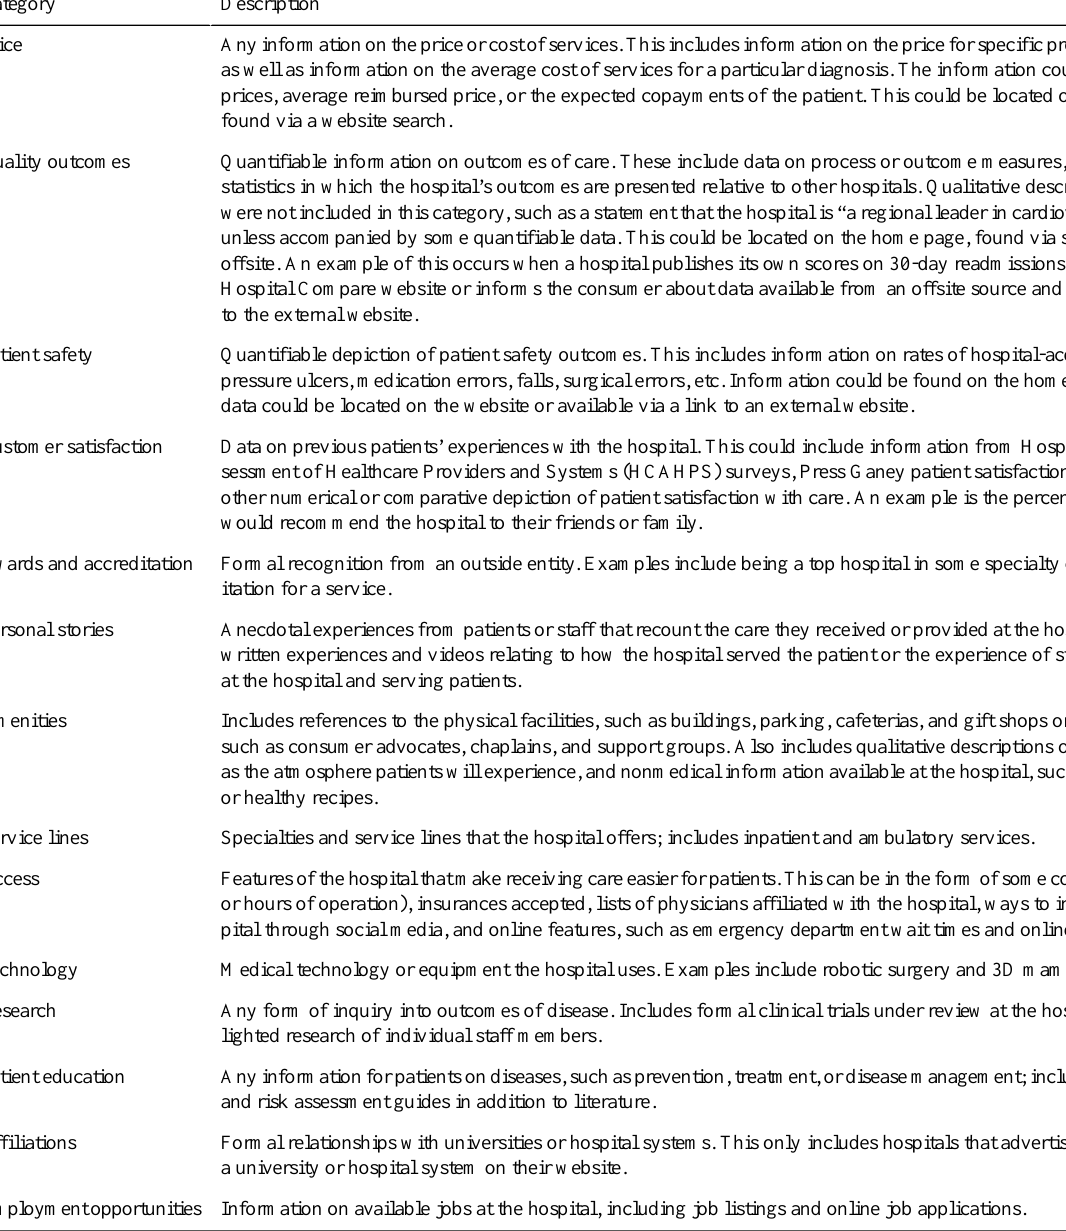
Table 2. Categories of advertising on hospital